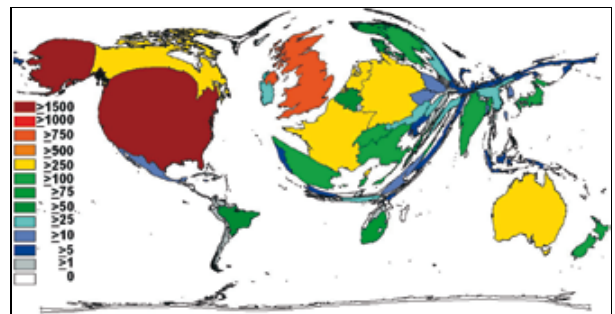
Fig. 3. Density-equalising map illustrating the number of publications in each country. The area of each country was scaled in proportion to its total number of publications on